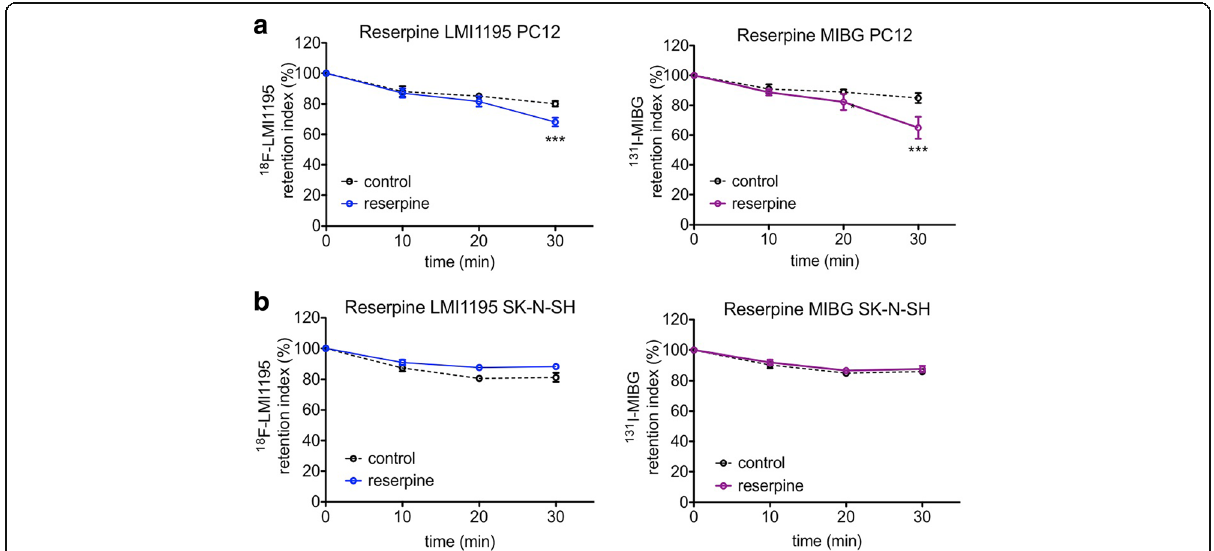
Fig. 3 Time course of tracer retention index after the stimulation with reserpine. Both tracers are induced to be released from PC12 cells after reserpine treatment ( a n = 6 at each time point of both groups), whereas such effect could not be observed in SK-N-SH cells ( b n = 6 at each time point of both groups). *** p < 0.001 vs. control group at the same time point; all data points presented as mean ± SD